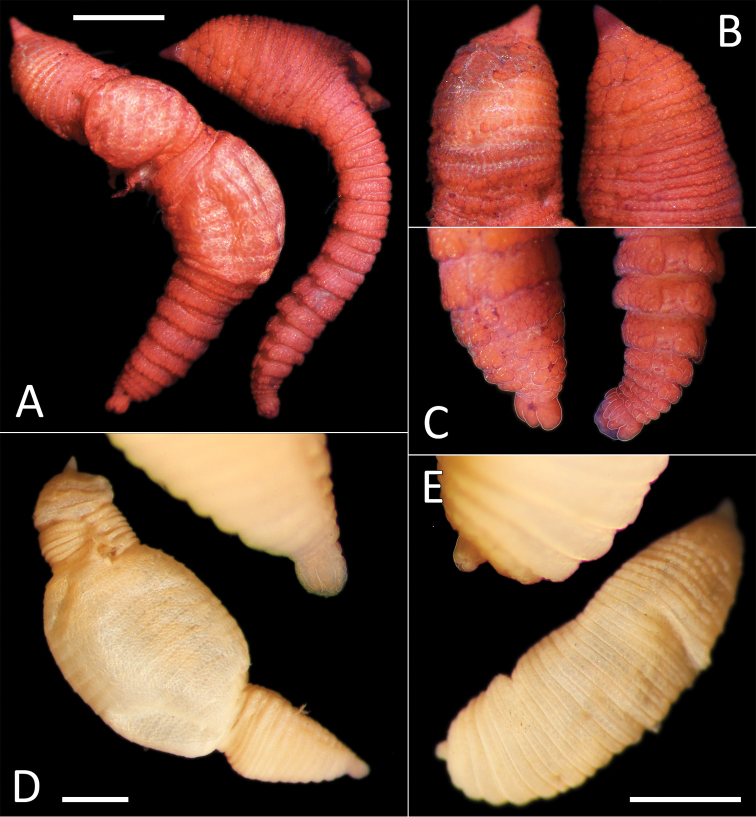
Comparison between Travisia sp. NHM_1244 and Travisia
zieglerae sp. nov., and holotypes of Travisia
glandulosa (BMNH 1921.5.1.2431) and Travisia
gravieri (BMNH 1921.5.1.2429). A Lab images, whole specimens (Travisia sp. NHM_1244 specimen NHM_1863 [left], Travisia
zieglerae sp. nov. holotype [specimen NHM_1431] [right], stained,) B Lab images, comparison of prostomia (Travisia sp. NHM_1244 specimen NHM_1863 [left], Travisia
zieglerae sp. nov. holotype [right], stained) C Lab images, comparison of pygidia (Travisia sp. NHM_1244, specimen NHM_1863 [left], Travisia
zieglerae sp. nov. holotype [right], stained) DTravisia
glandulosa holotype, with detail of pygidium ETravisia
gravieri holotype, with detail of pygidium. Morphological features in plates C–E have been outlined with a very fine white line to improve clarity of those features. Scale bars: 1 mm (A, D, E).